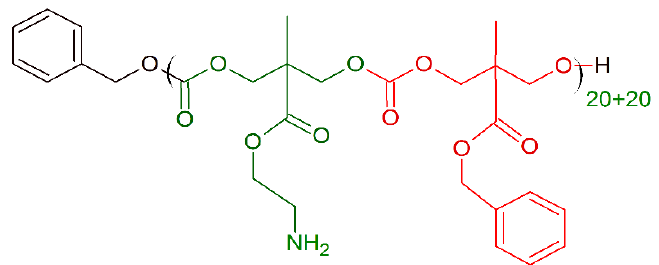
Figure 9. Schematic representation of the polycarbonate polymer with primary amino groups. Green: positively charged monomer; red: hydrophobic monomer.